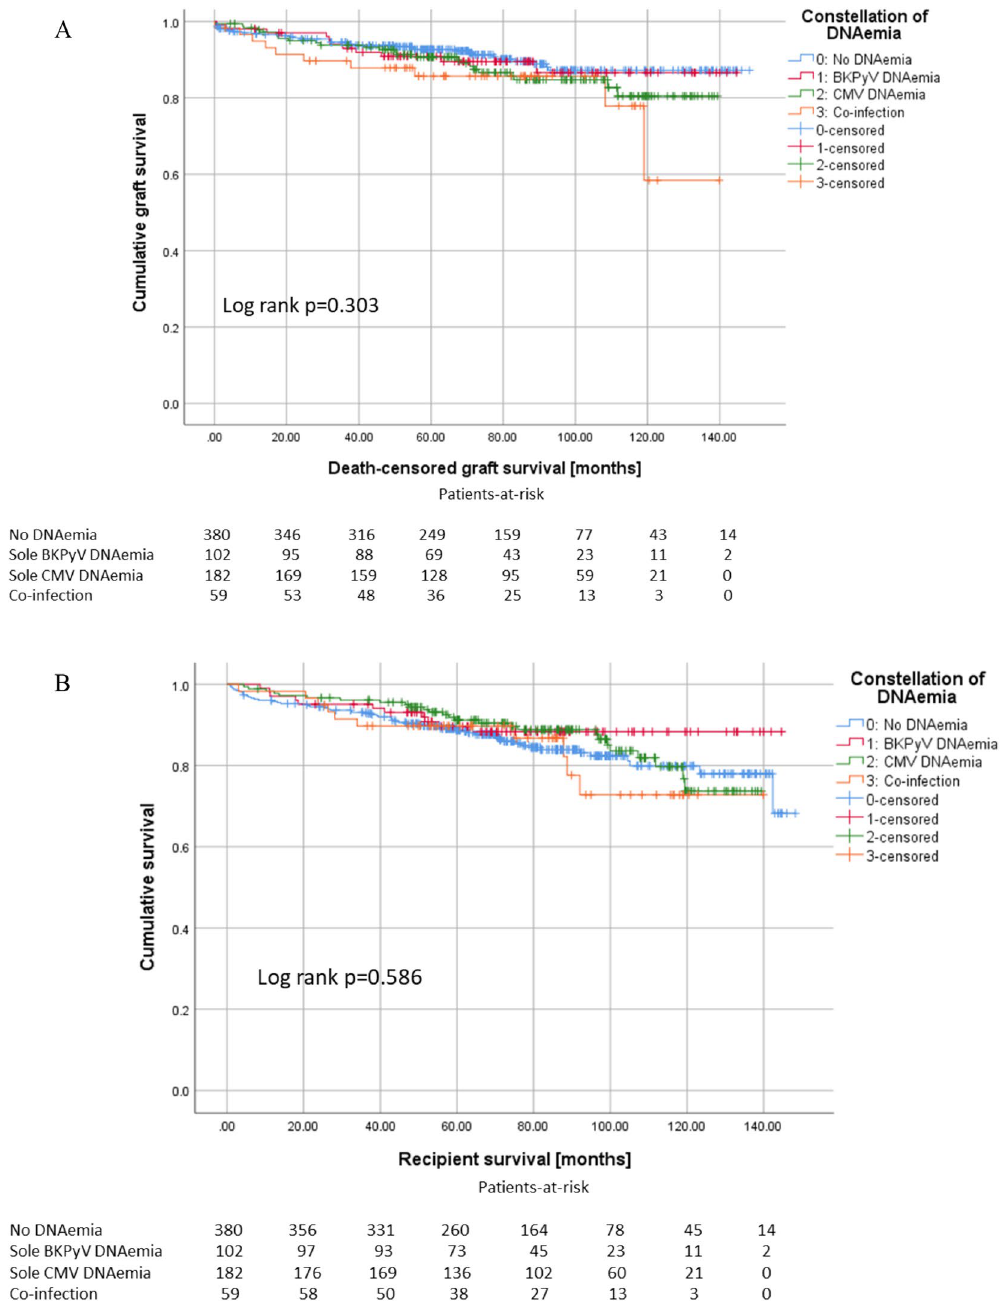
Figure 5. Co-infection with BKPyV and CMV does neither influence graft survival ( A ) nor recipients’ survival ( B